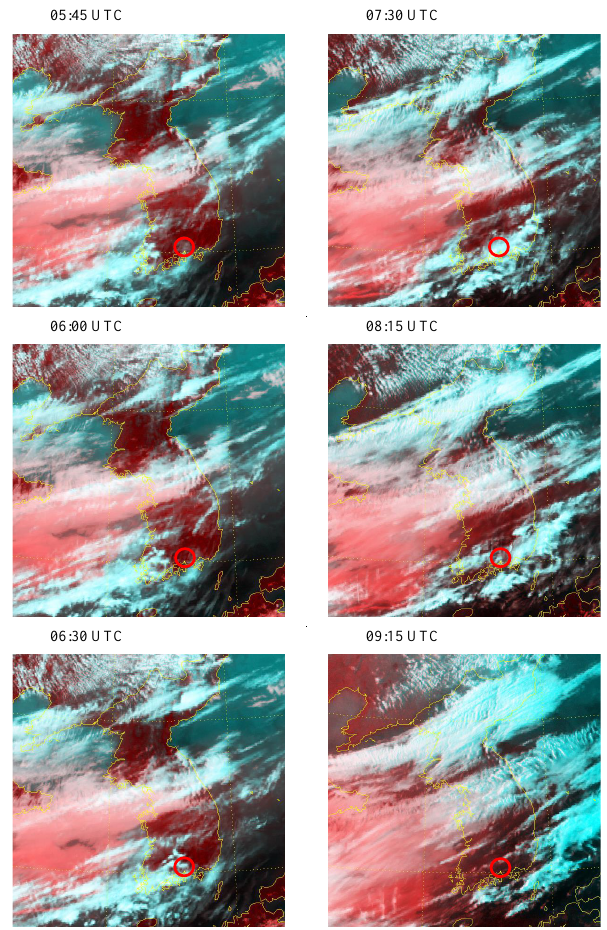
Figure 13. False color composite image (using visible, infrared window, and water vapor images) for the time used in the closer comparison of the IRT and the ceilometer. The time sequence im- ages clearly show the approaching high clouds and a glimpse of thickening clouds over the observation station (located around the center of the red